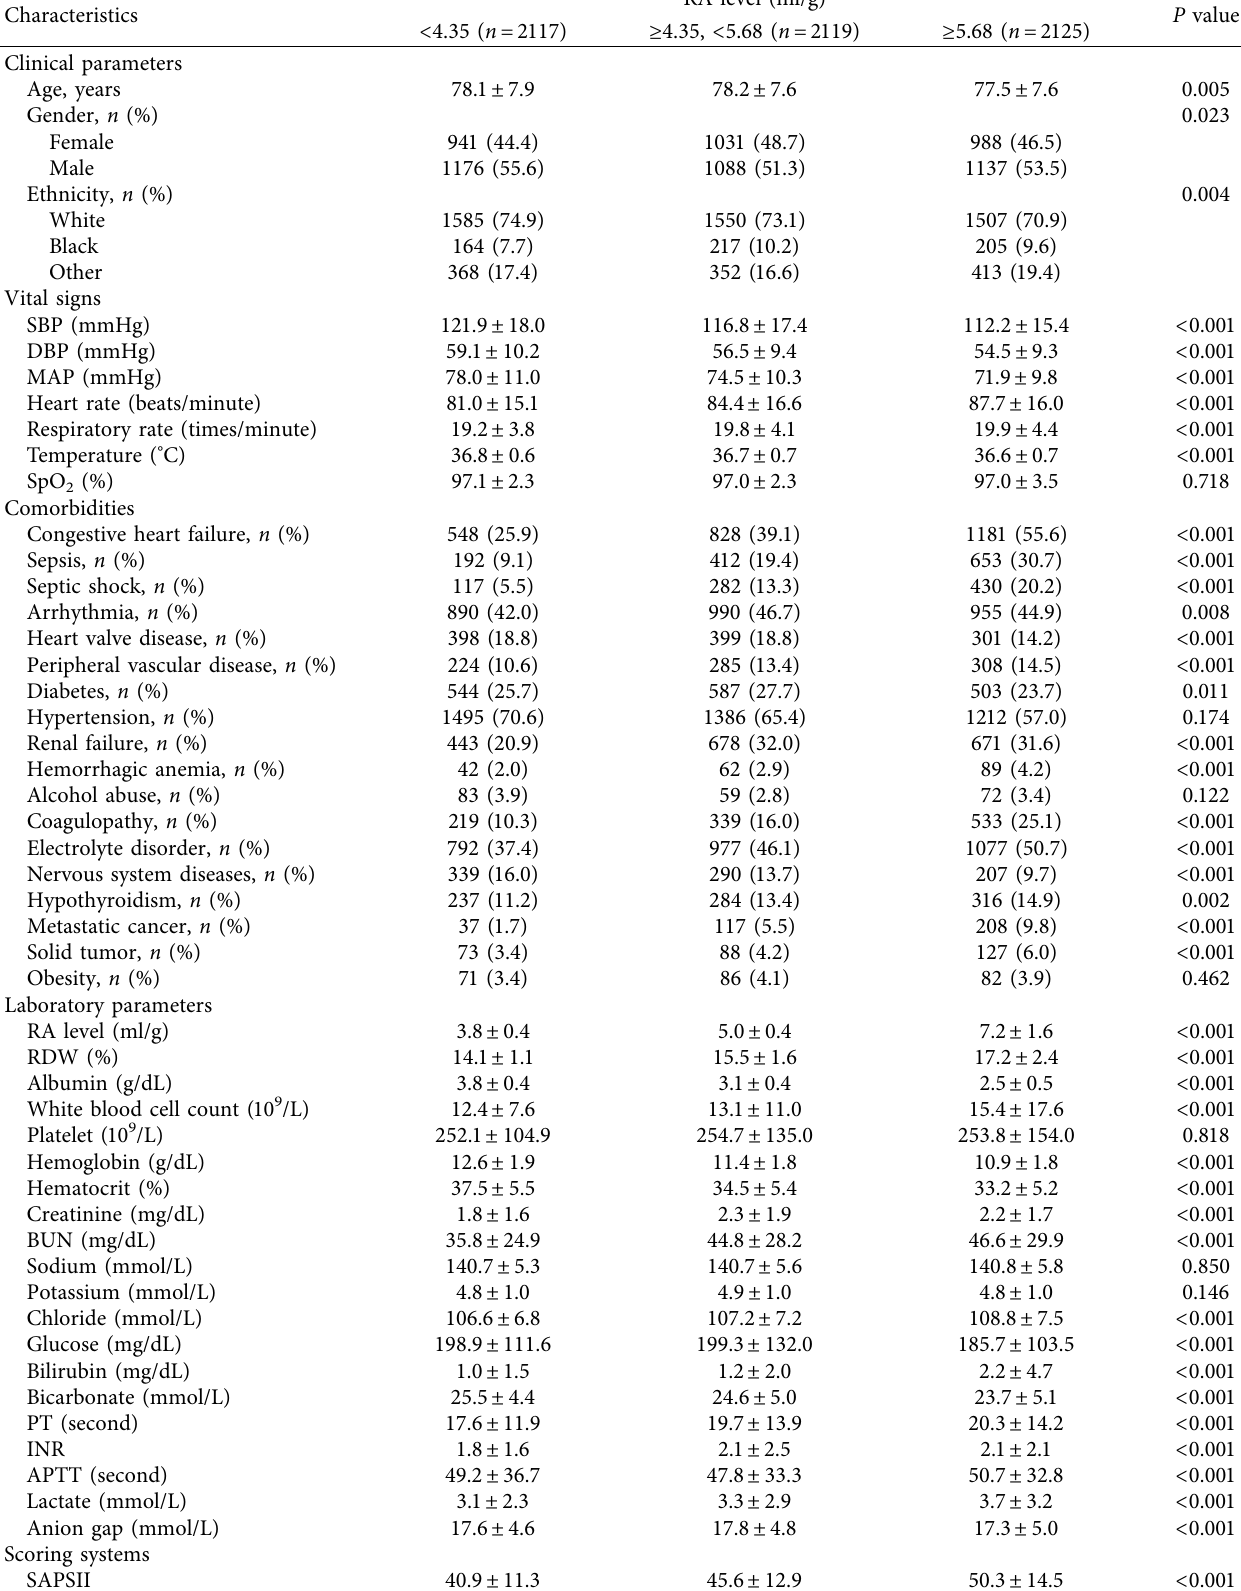
Table 1: Baseline characteristics of the study